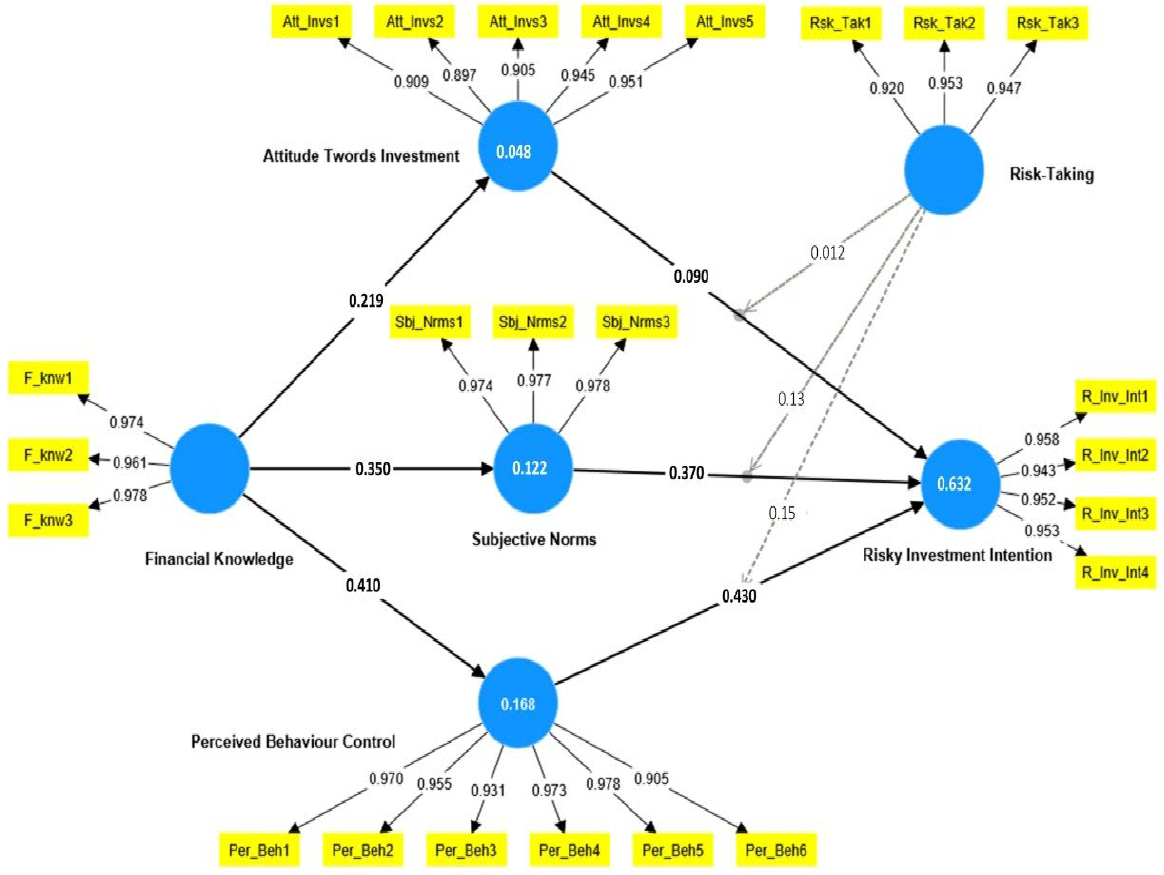
Figure 2. Inner and Outer model.